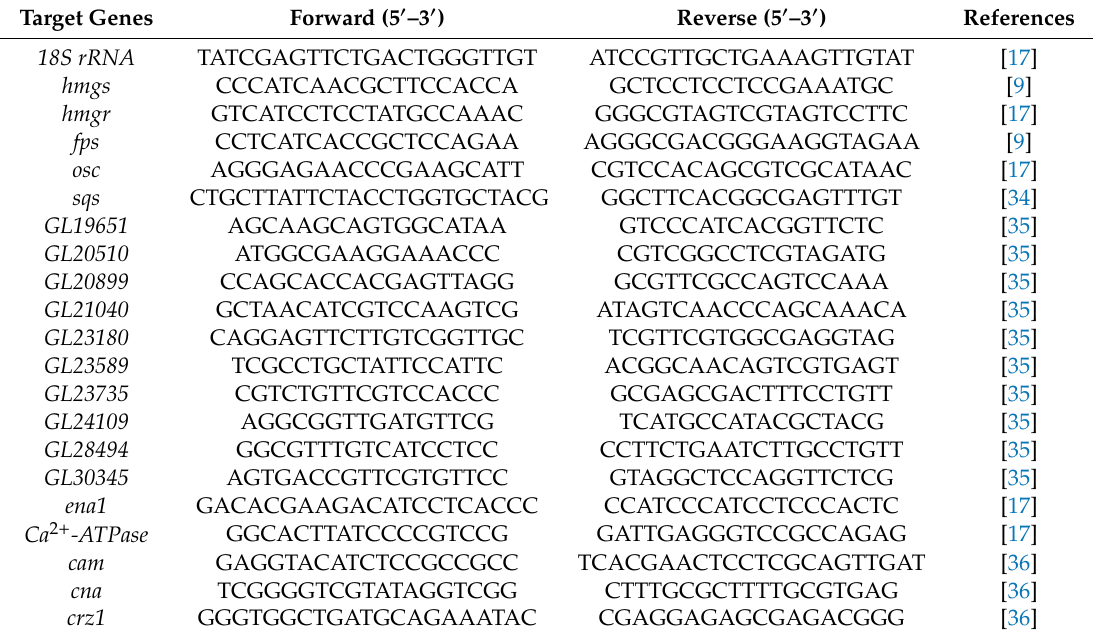
Table 1. Primer pairs used for qRT-PCR in this